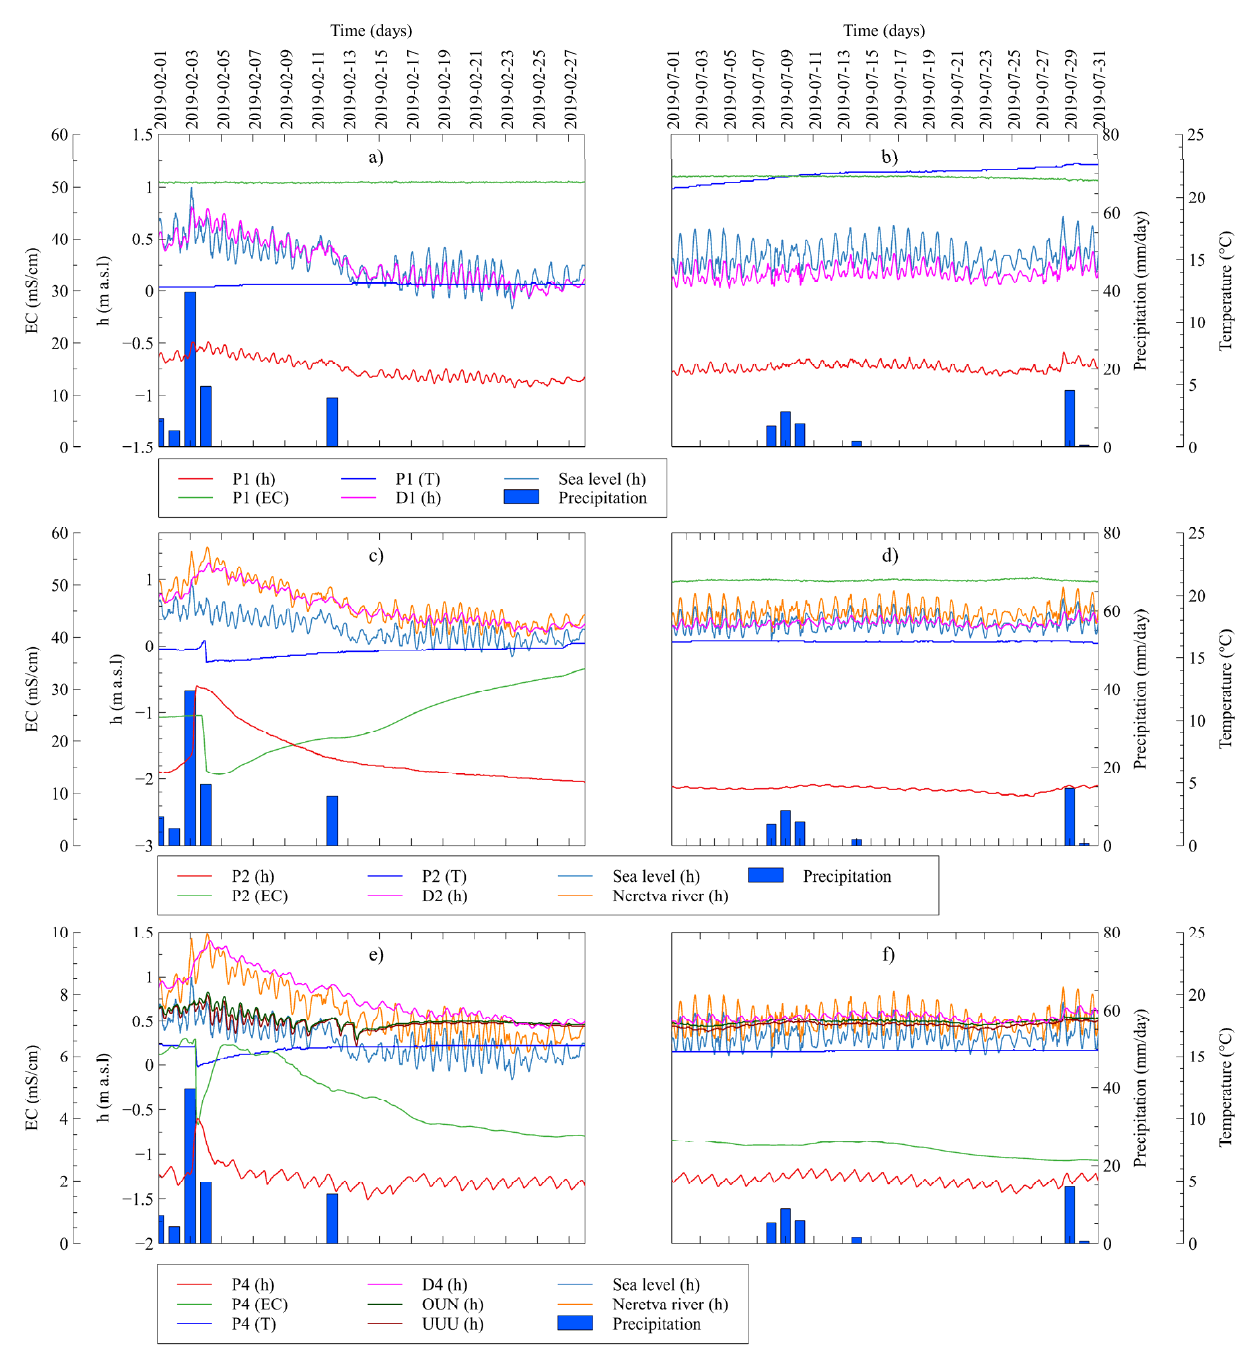
Figure 5. Observed time series from Neretva valley coastal aquifer system: ( a ) h in confined aquifer D1, h, T and electrical conductivity (EC) in unconfined aquifer P1, sea level and precipitation during February 2019; ( b ) h in confined aquifer P1, h, T and EC in unconfined aquifer P1, sea level and precipitation during July 2019; ( c ) h in confined aquifer D2, h, T and EC in unconfined aquifer P2, sea level, river surface elevation and precipitation during February 2019; ( d ) h in confined aquifer D2, h, T and EC in unconfined aquifer P2, sea level, river surface elevation and precipitation during July 2019; ( e ) h in confined aquifer D4, h, T and EC in unconfined aquifer P4, sea level, river surface elevation, OUN h and UUU h and precipitation during February 2019; ( f ) h in confined aquifer D4, h, T and EC in unconfined aquifer P4, sea level, river surface elevation, OUN and UUU h and precipitation during July